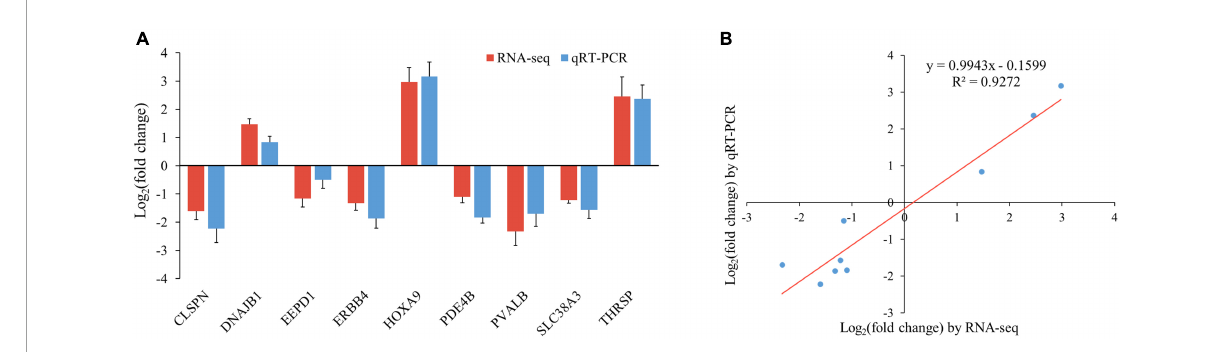
FIGURE6 Verification of RNA-seq data by qRT-PCR. (A) Histogram of RNA-seq and qRT-PCR expression levels. X-axis represents 9 selected genes, and Y-axis represents the expression levels of genes from RNA-seq and qRT-PCR. (B) The liner regression analysis of expression level between RNA-seq and qRT-PCR data. The X-axis represents the log 2 fold change of RNA-seq, and the Y-axis indicates the log 2 fold change of